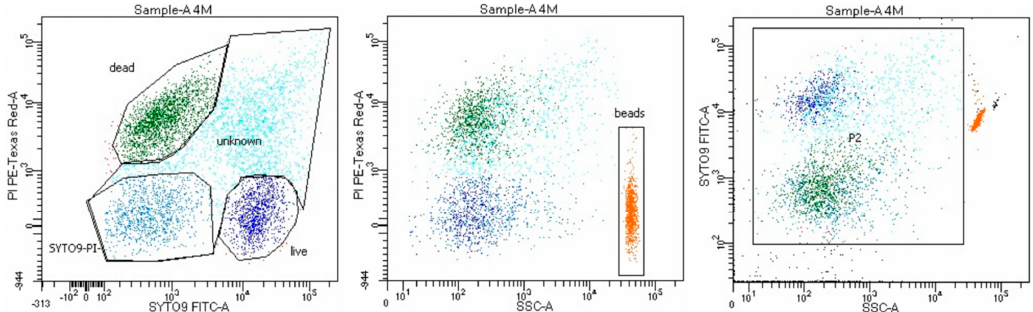
Figure 1. Gating strategy shown on one of the samples. SYTO9 ‐ positive PI ‐ negative cells were considered alive, SYTO9 ‐ negative PI ‐ positive cells were considered dead, other cells were considered as unknown, with special gating on SYTO9 ‐ negative PI ‐ negative cells, which were called “double negative” cells.